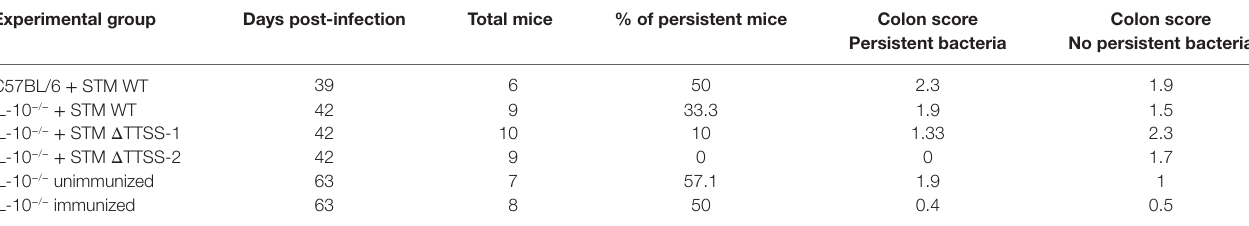
colon score Persistent bacteria no persistent bacteria